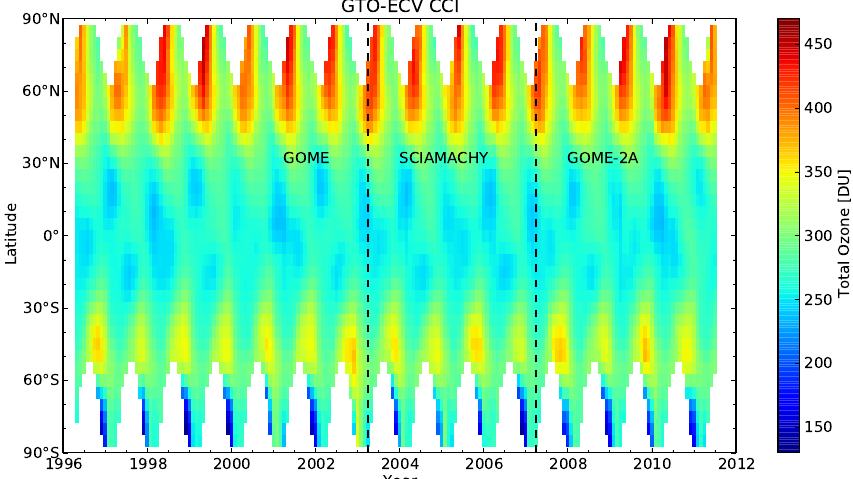
Figure 3. GTO-ECV CCI total ozone column data record 1996–2011 as a function of latitude. Vertical black dashed lines indicate the change-over from GOME to SCIAMACHY in April 2003 and from SCIAMACHY to GOME-2A in April 2007.